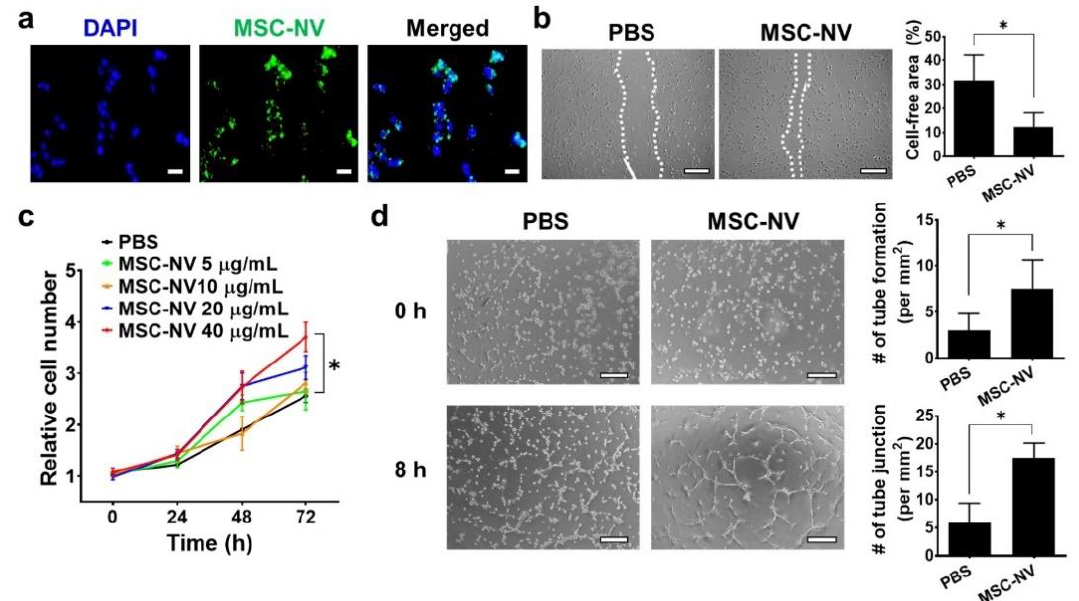
Figure 3. ( a ) Fluorescence microscopy image of human umbilical vein endothelial cells (HUVECs) treated with DiO (green)-stained MSC-NVs (40 µ g/mL). Cells were observed at 2 h post-treatment of MSC-NVs. DAPI = nuclei, scale bar = 50 µ m. ( b ) Migration of HUVECs treated with PBS or MSC-NVs (40 µ g/mL) in serum-free medium at 24 h post-treatment. Scale bar = 100 µ m. For quantitative analysis, the cell-free area was measured. n = 3, * p < 0.05. ( c ) Proliferation of HUVEC until 72 h after treatments with various concentrations of MSC-NVs (5–40 µ g/mL). n = 5, * p < 0.05. ( d ) Tube formation of HUVECs at 0 h and 8 h after treatment with PBS or MSC-NVs (40 µ g/mL). Tube formation and tube junctions were counted for quantification. Scale bar = 100 µ m, n = 3, * p < 0.05. Three independent experiments were carried out, and the p -values were calculated by a two-tailed t -test.